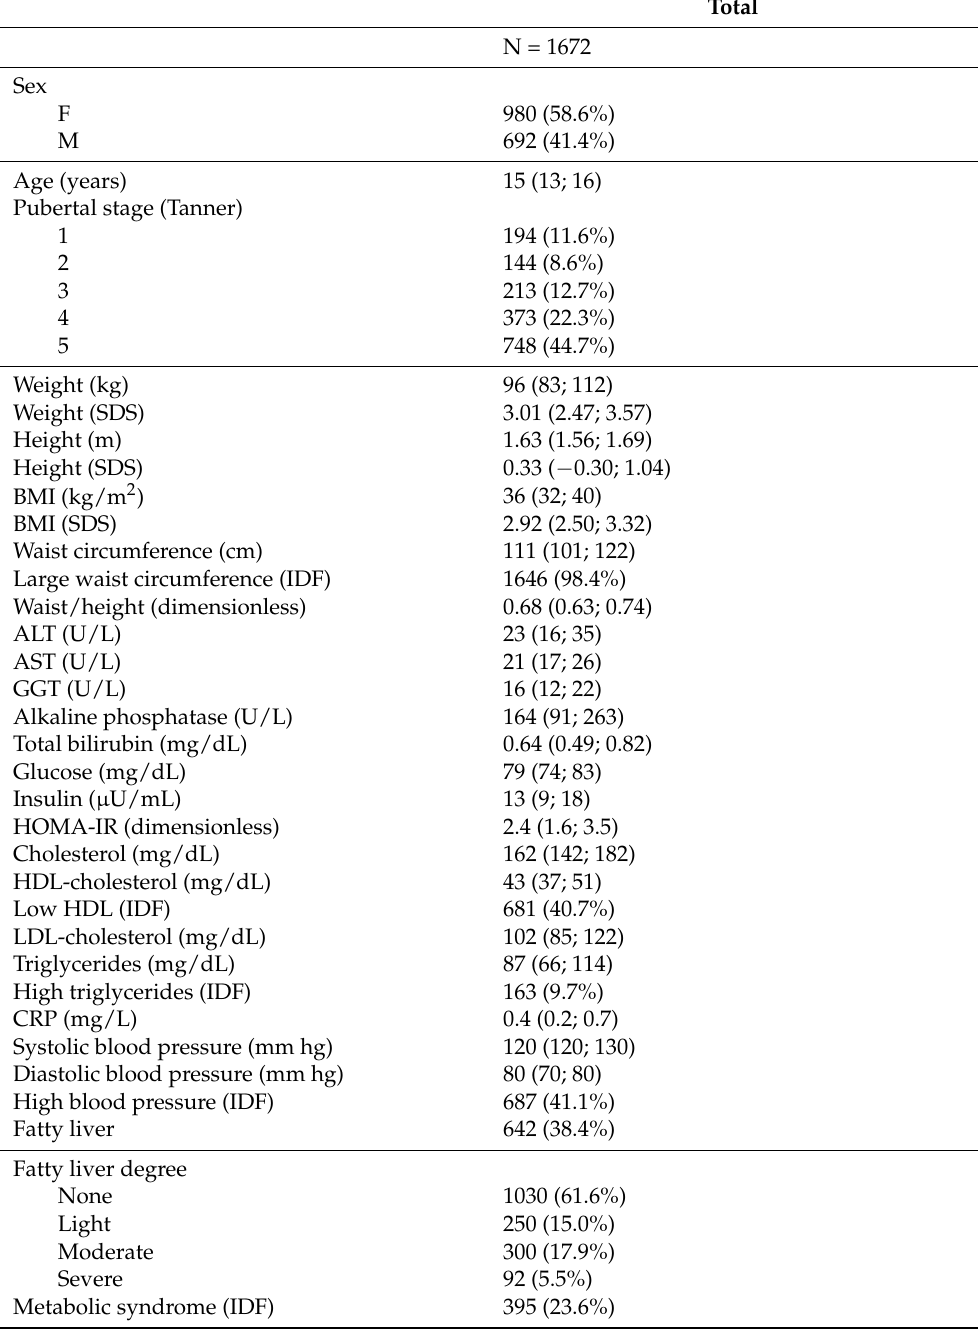
Table 1. Measurements of the study children. Abbreviations: BMI = body mass index; SDS = Standard deviation score); and interquartile range (IQR, 25th and 75th percentiles). Discrete variables are reported as the number and proportion of subjects with the characteristic of